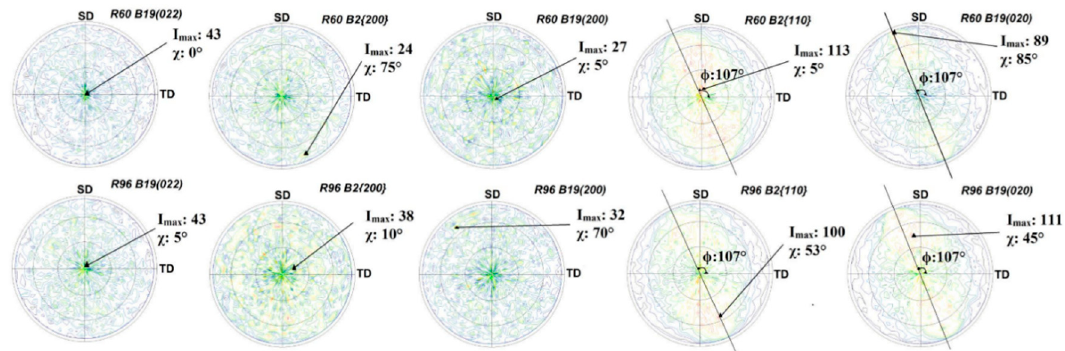
Figure 6. Wheel-side pole figures of R60 and R96 ribbons with spinning (SD) and transverse directions (TD) as reference. Table 1. Pole figure maximum intensities for R60 and R96